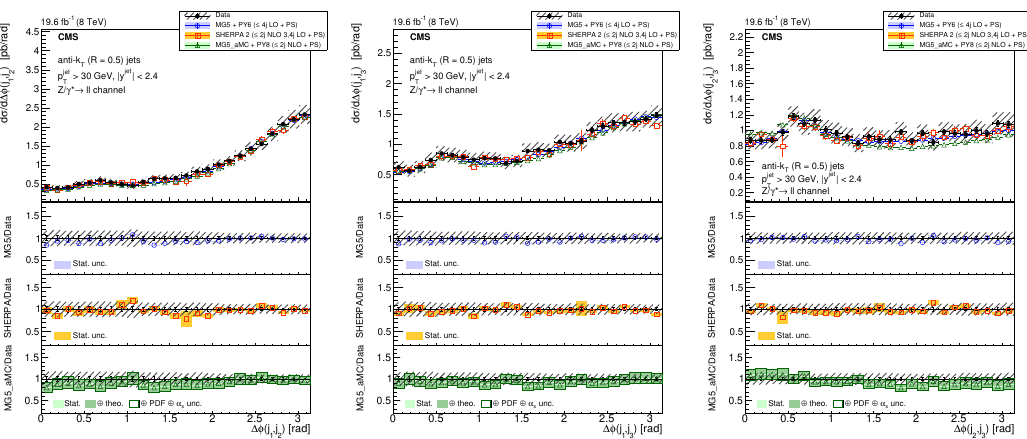
Figure 24 . The di(cid:11)erential cross section for Z ( ! ‘‘ )+jets production for N jets (cid:21) 3, p Z and H jet > 300 GeV as a function of the azimuthal angle between the Z boson and the (left) (cid:12)rst-, T (middle) second-, and (right) third-leading jet. The lower panels show the ratios of the theoretical predictions to the measurements. Error bars around the experimental points show the statistical uncertainty, while the cross-hatched bands indicate the statistical and systematic uncertainties added in quadrature. The boxes around the mg5 a mc + pythia 8 to measurement ratio represent the uncertainty on the prediction, including statistical, theoretical (from scale variations), and PDF uncertainties. The dark green area represents the statistical and theoretical uncertainties only, while the light green area represents the statistical uncertainty alone.